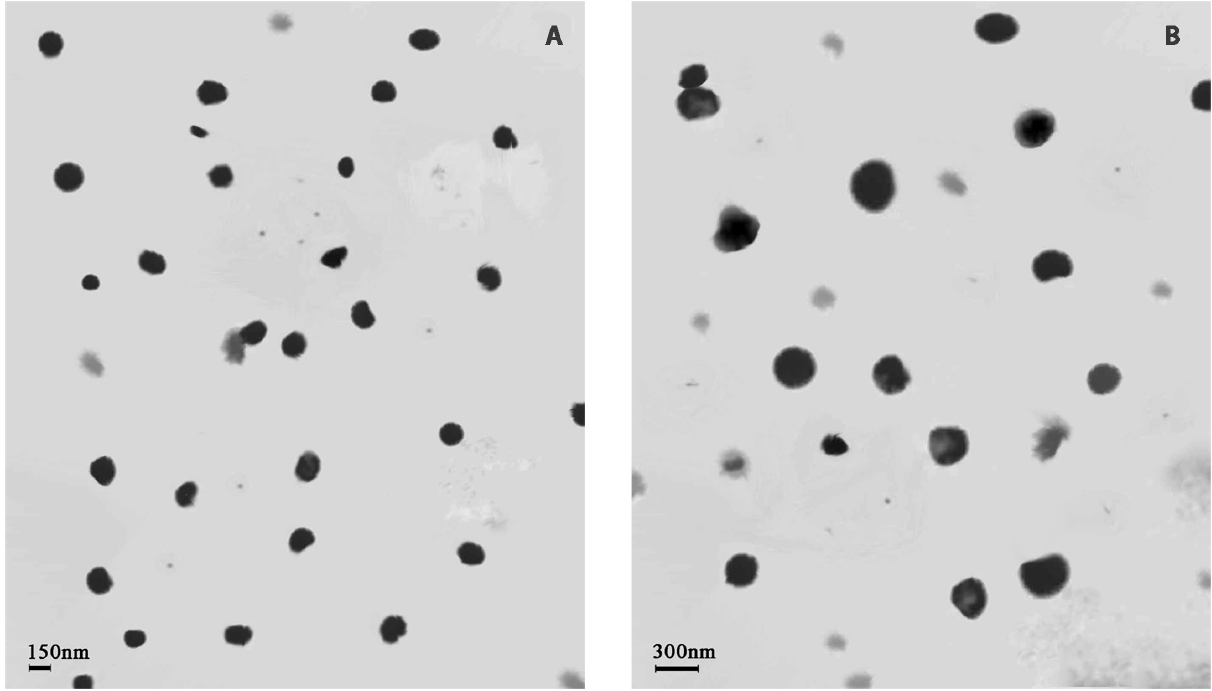
Figure 1. ( A ) TEM image of chitosan-TPP nanoparticles and ( B ) M. eupeus venom-loaded chitosan-TPP nanoparticles (chitosan: 48 kDa, 2 mg/mL; M. eupeus venom 500 µg/mL).